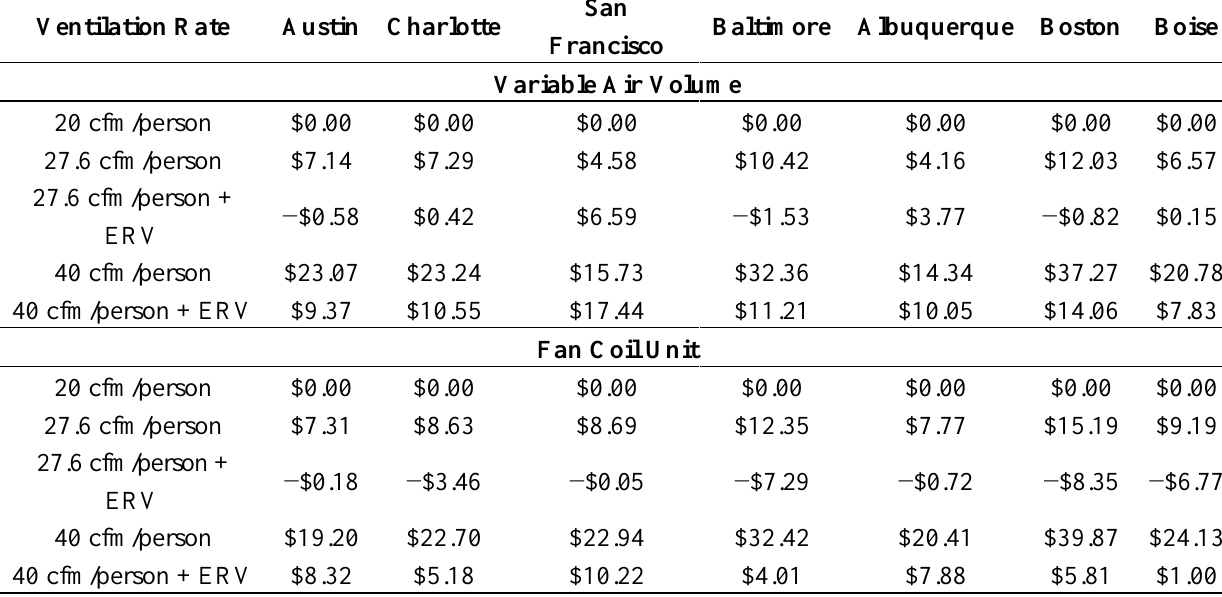
Table 2. Change in energy cost per occupant per year compared to conventional. San Ventilation Rate Austin Charlotte Baltimore Albuquerque Boston Francisco